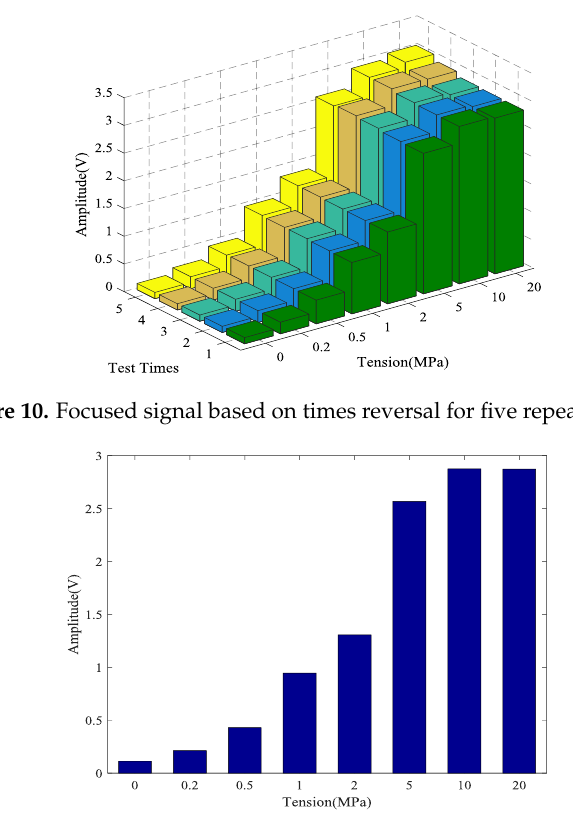
Figure 9. Focused signal based on the time reversal method at different tension levels.